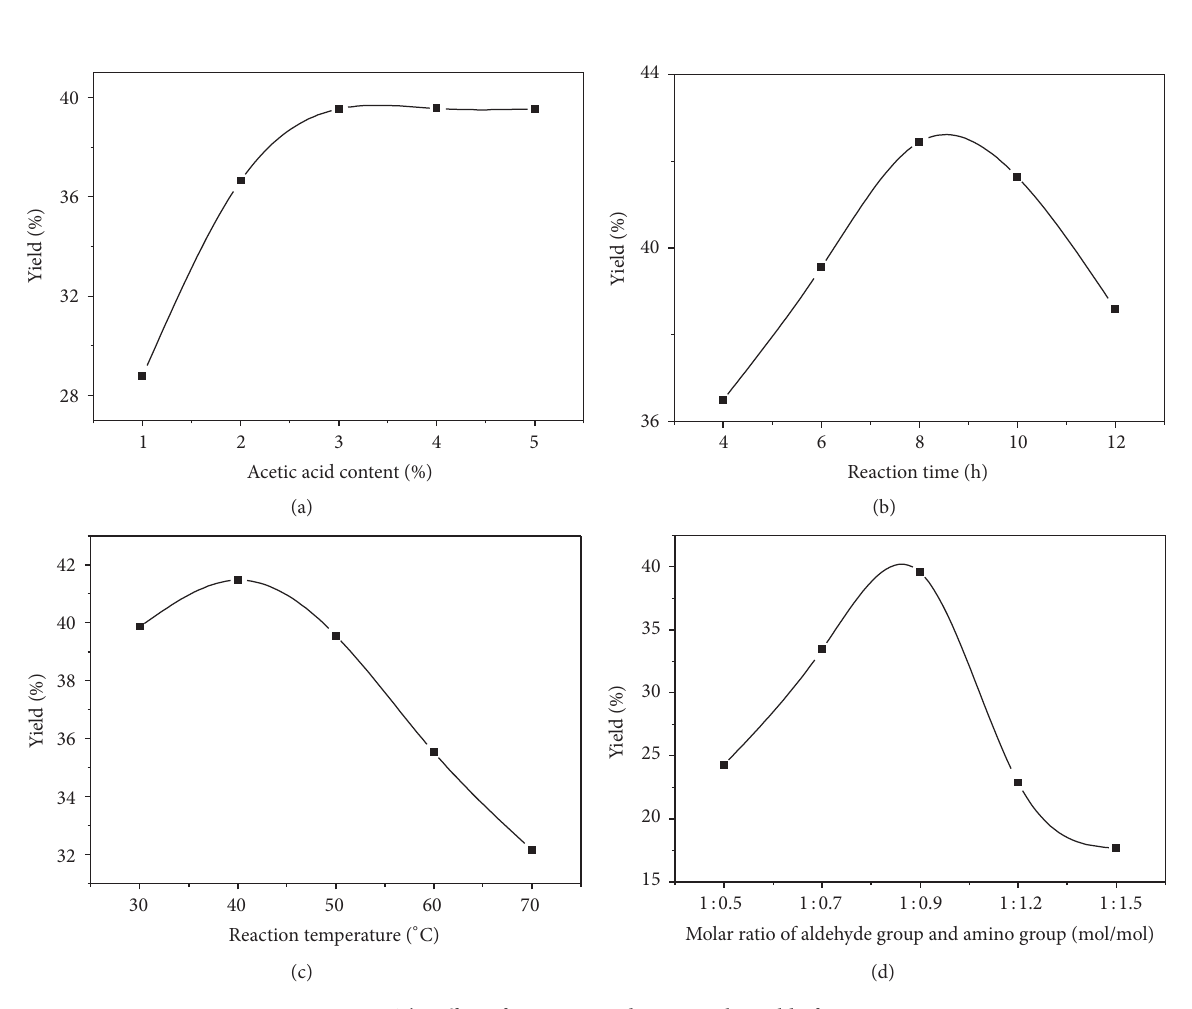
Figure 1: The effect of reaction conditions on the yield of